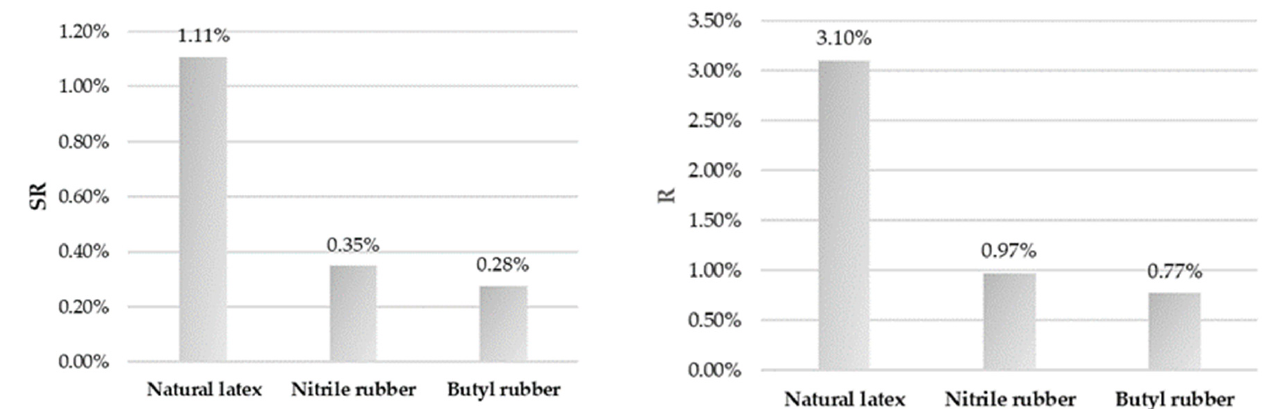
Figure 2. Uncertainty budget for the repeatability of the performed measurements (on the left) and the repeatability limits (on the right).